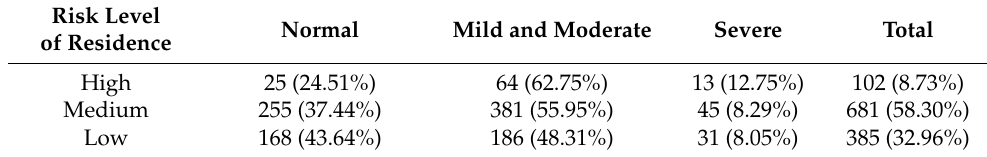
Table 5. The impact of the risk level of the residence on anxiety.